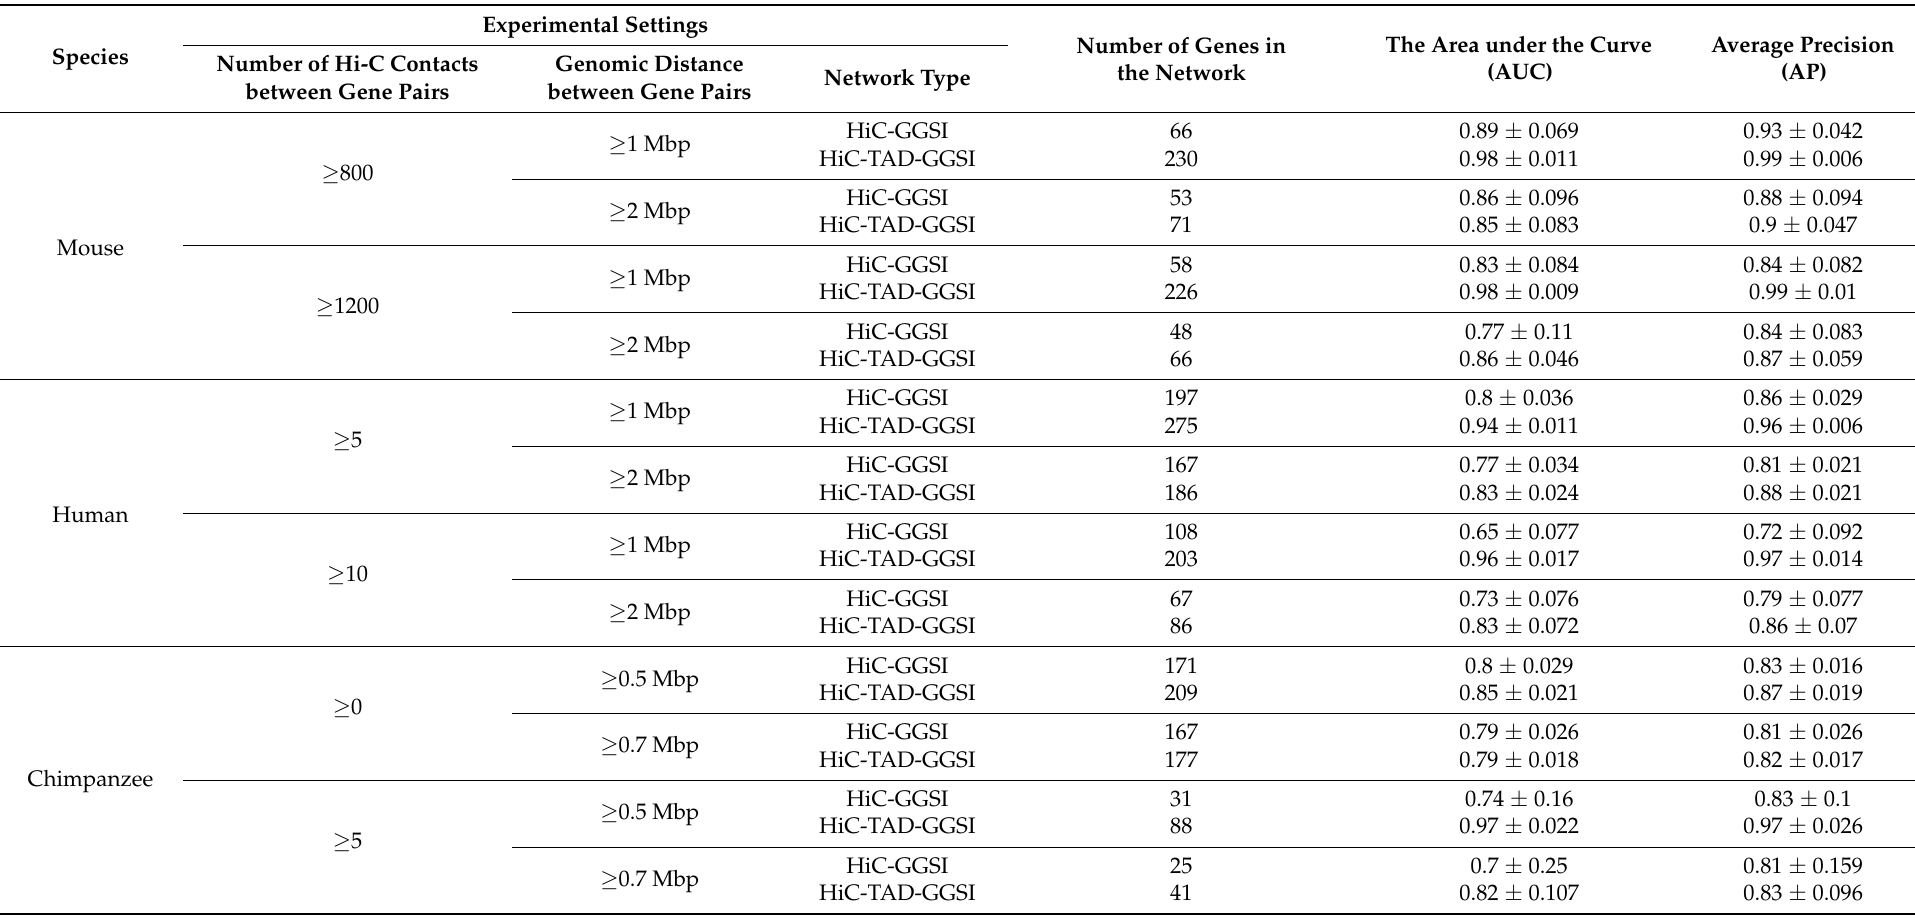
Table 2. The performance of the graph autoencoder when it was used to reconstruct the HiC-GGSI and HiC-TAD-GGSI networks at different Hi-C contact and genomic distance thresholds on the X-chromosomes of the mouse, human, and chimpanzee. We calculated the 95% confidence interval with ten repeated